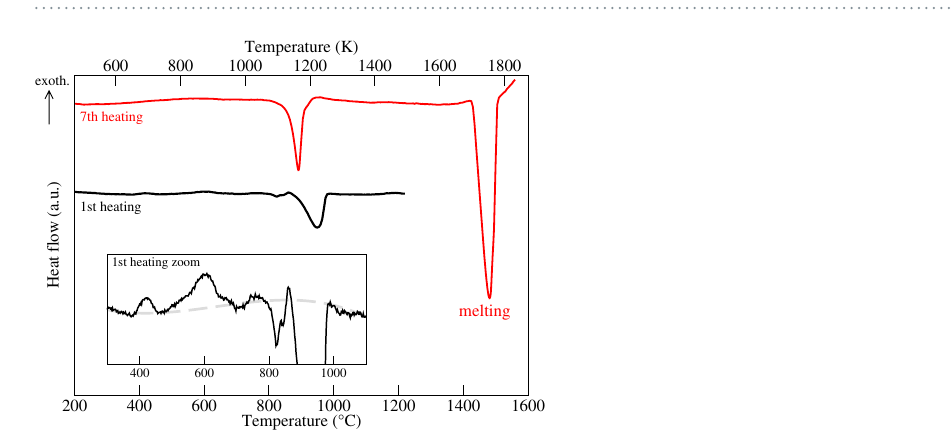
Figure 6. X-ray analysis of the Al 15 Hf 25 Sc 10 Ti 25 Zr 25 at.% HEA in the as cast state (lower panel) and after annealing (upper